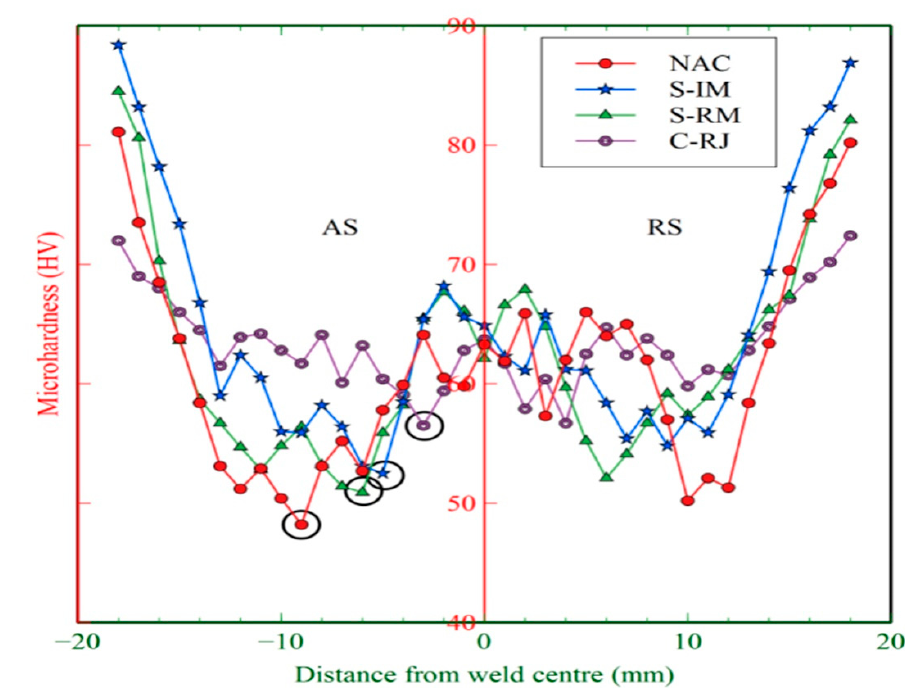
Figure 9. Hardness distribution across the joints obtained in different cooling